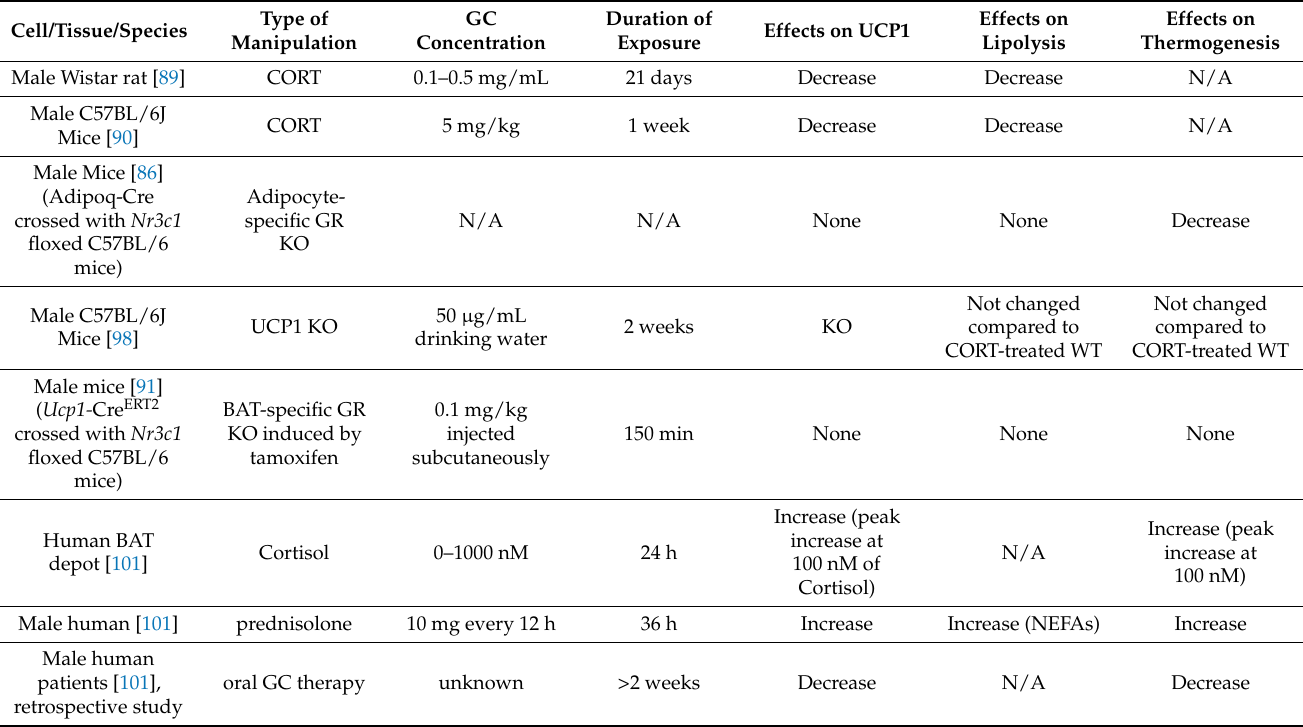
Figure 2. Effects of GCs on lipid metabolism in BAT. The effects of GCs on lipolysis in BAT appear to be independent of UCP1 and the GR. Multiple potential mechanisms in BAT include the effects of the extracellular FA availability on GCs’ induced lipid accumulation. Table 2. Summary of effects of GC gain/loss of function of GCs in BAT.